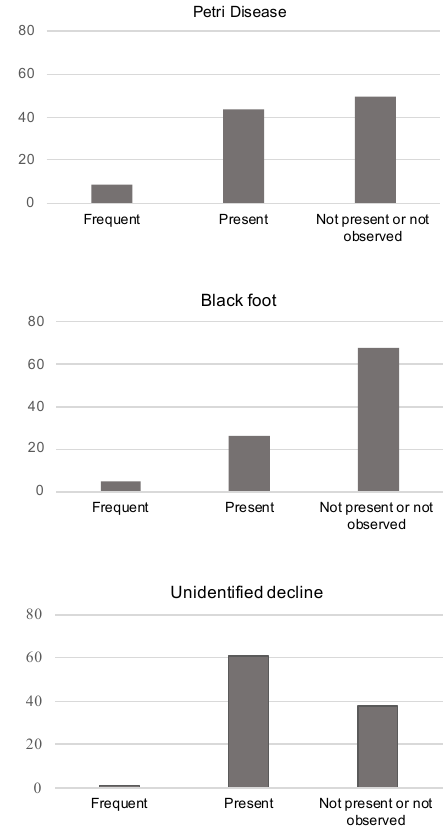
Figure 5. Proportions (%) of survey reports from all countries of different grapevine decline syndromes on young vines.